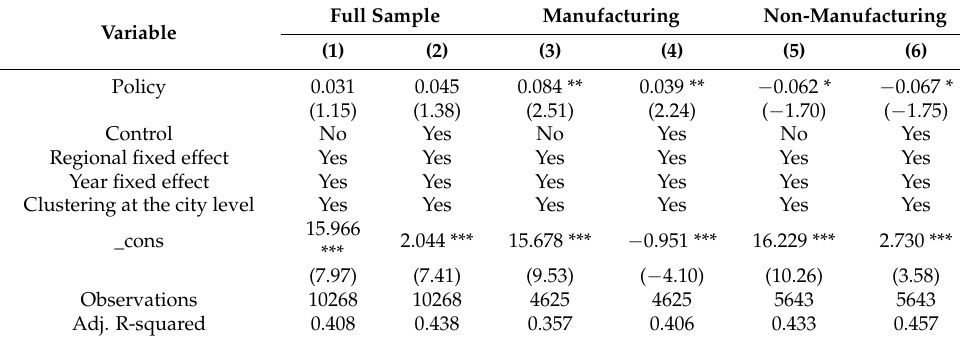
Table 13. Effects of low-carbon city construction (LCC) on various types of patent applications of listed companies. Full Sample Variable